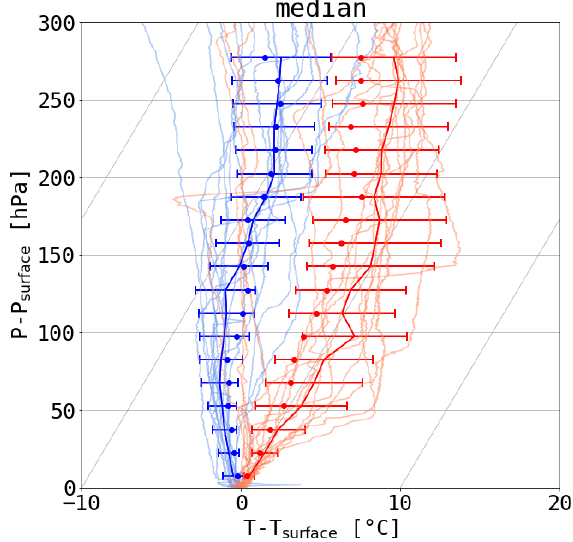
Figure 8. Skew T – P diagram of air temperature relative to the surface air temperature from radiosoundings (thin lines) during cold (blue) and warm (red) temperature advection events. The y axis shows the pressure relative to the surface pressure. The thick lines and error bars show the median and standard deviation in ev- ery 15hPa pressure bin. The dots show the median profiles from COSMO iso for the same cold and warm temperature advection events as sampled by the